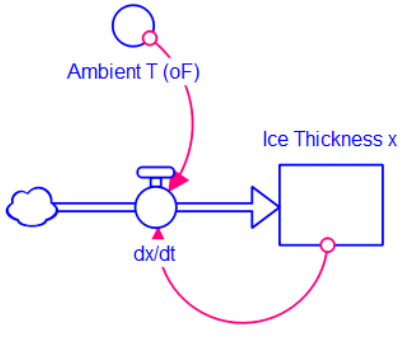
Fig. 14. Stock and flow diagram for Ice Freezing on Pond Surface